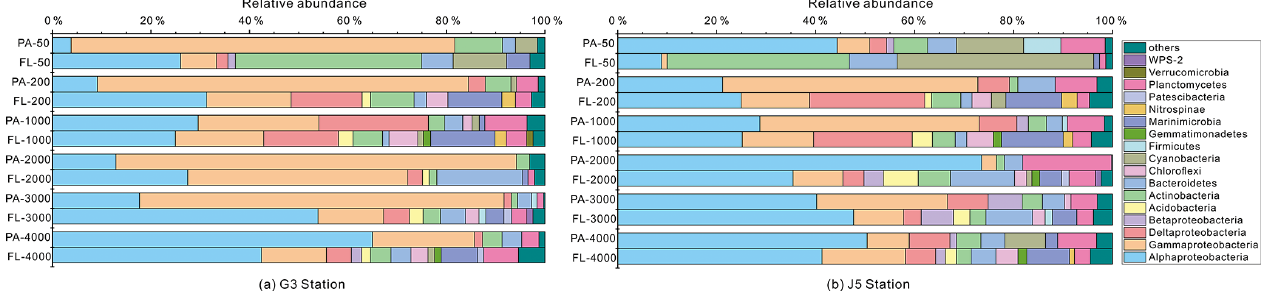
Figure 5. Taxonomic compositions of particle-attached and free-living bacterial communities of seawaters at different depths along two different water columns in the South China Sea. (a) G3 station; (b) J5 station. The phylum or class which has less than 1% proportions is classified into “others” (Fig. S5).